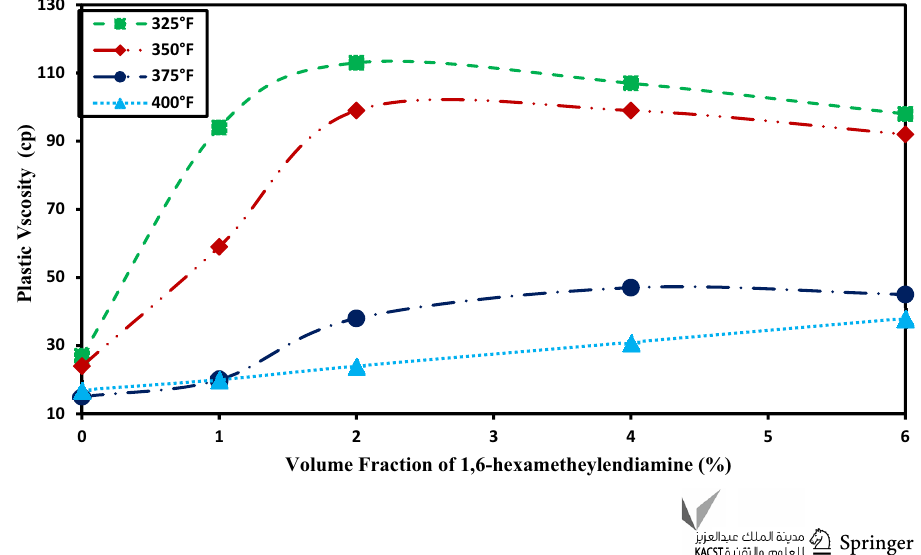
Fig. 8 Effect of the combination of 1,6-hexamethylenediamine and PAC on plastic